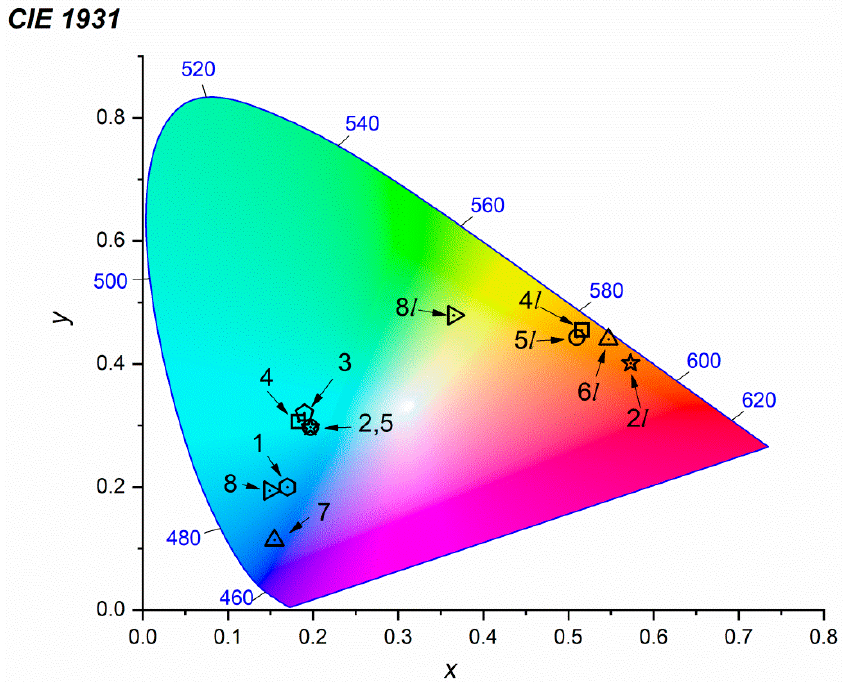
Figure 20. Color space chromaticity diagram of the studied samples coloration: (1) irradiated cancrinite, (2) kyanoxalite, (3) irradiated kyanoxalite, (4) afghanite from Sar-e Sang, (5) afghanite from Ladgvardara. Color coordinates of lazurite (7) [6] and slyudyankaite (8) [42] are shown for comparison. Chromaticity diagram of S 2 •− radical anion luminescence are given for: 2 l— kyanoxalite; 4l— afghanite from Sar-e Sang ; 5l— afghanite from Ladgvardara ; 6l— nosean ; 8l—